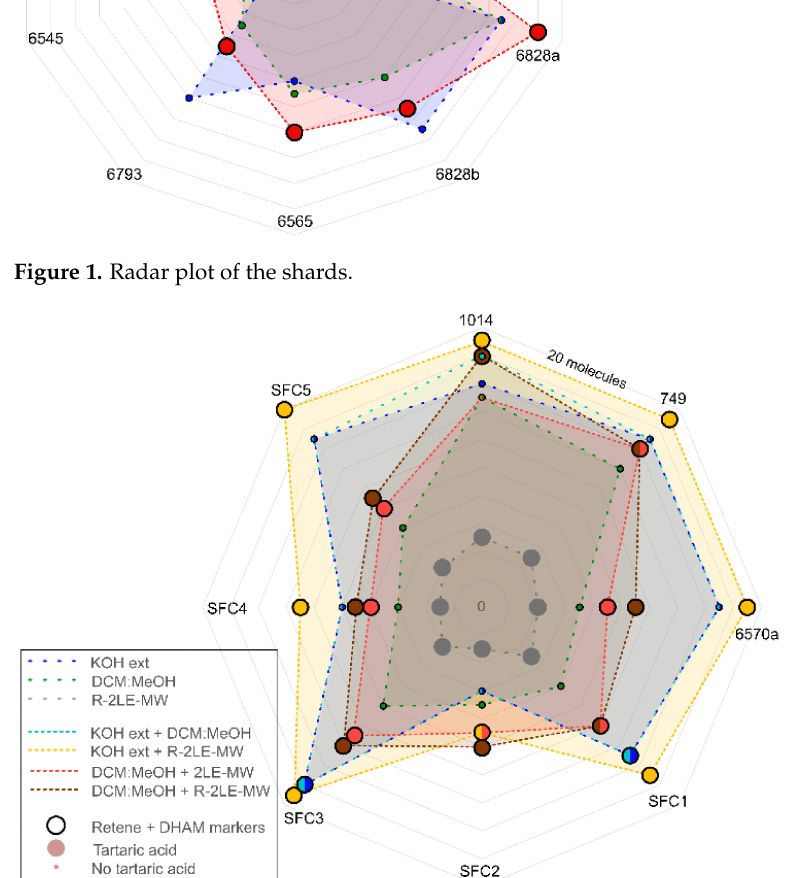
Figure 2. Radar plot of the coating